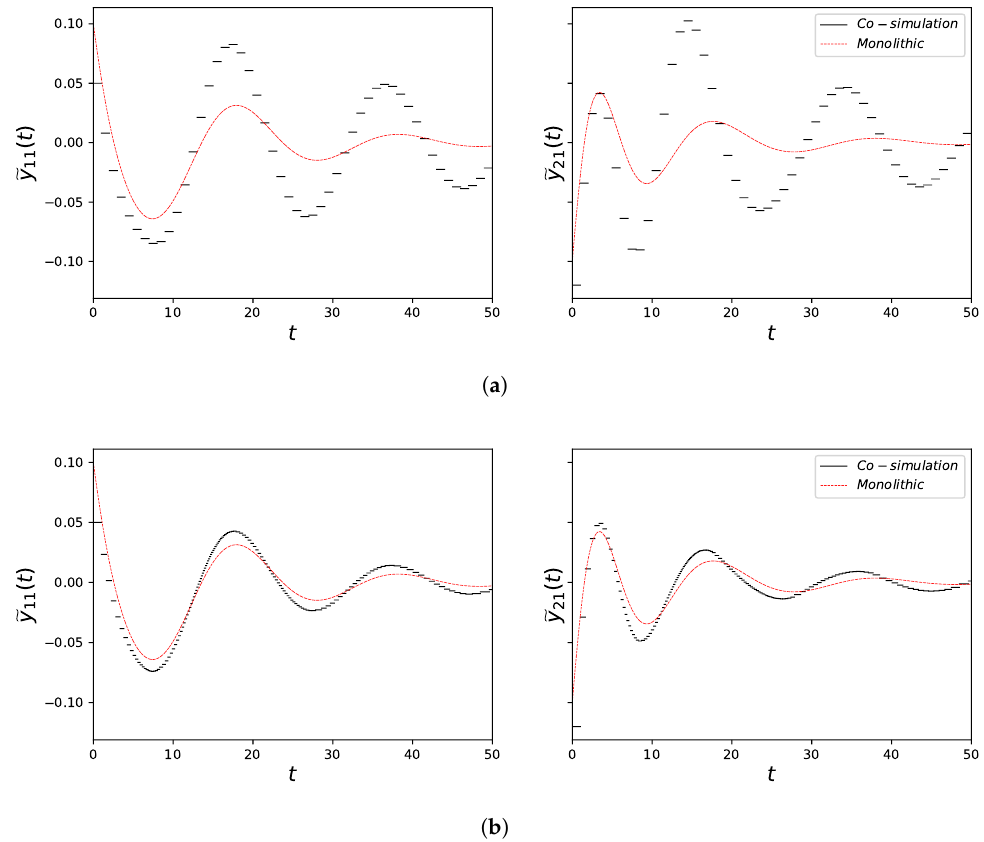
Figure 4. The diagrams show numerical solutions that were calculated with the Jacobi co-simulation method (Algorithm 1). The numerical solutions are compared with the monolithic solution: ( a ) Fixed step; ( b ) Variable